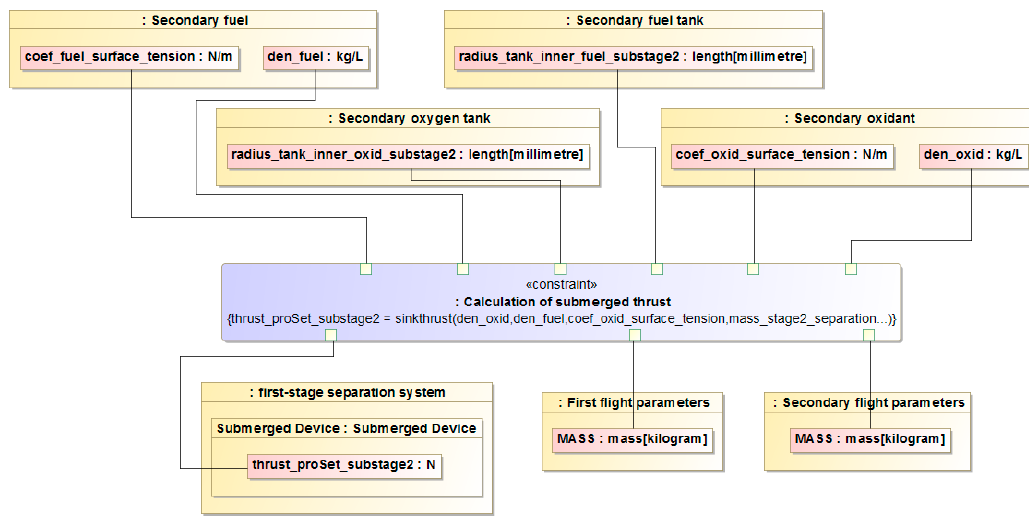
Figure 9. Calculation of submerged thrust.